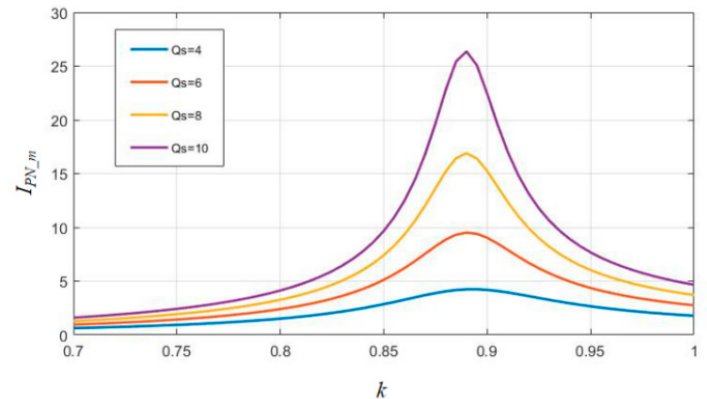
Figure 3. Component of the third harmonic with variation of coupling coefficient.